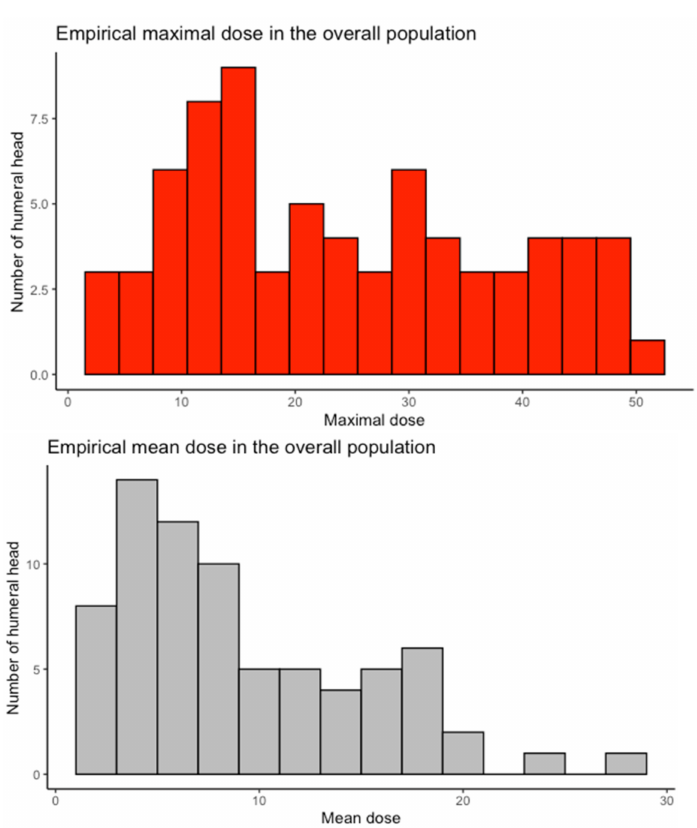
Figure 2. Empirical distribution of maximum and average doses received by the humeral head.